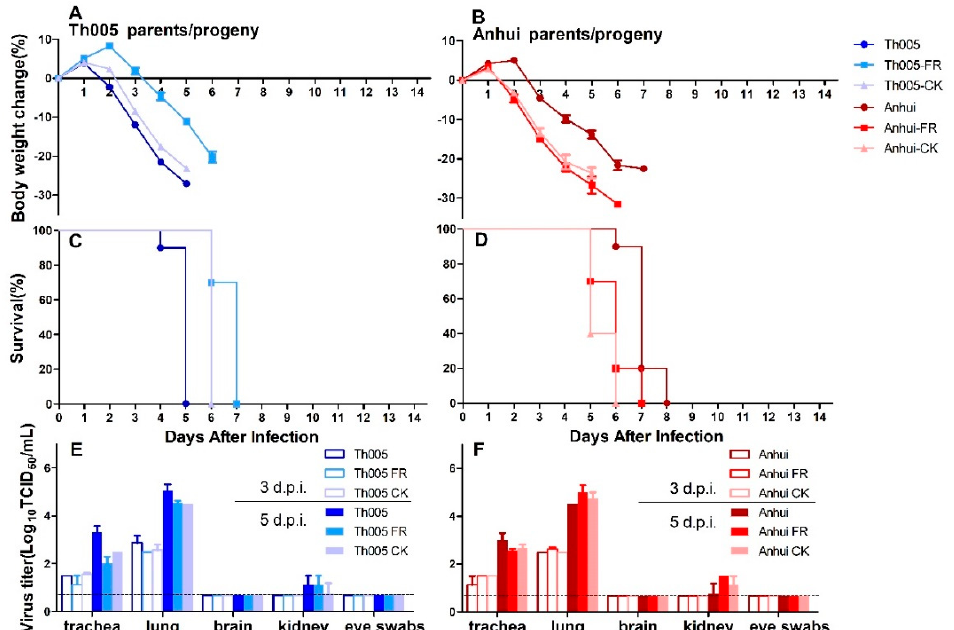
Figure 4. Pathogenicity of Th005, Th005 FR, Th005 CK, Anhui, Anhui FR, and Anhui CK infection in mice. Body weight change rate: ( A )Th005, Th005 FR, and Th005 CK. ( B )Anhui, Anhui FR, and Anhui CK. Survival rate: ( C ) Th005, Th005 FR, and Th005 CK. ( D )Anhui, Anhui FR, and Anhui CK. Viral titers in mice viscera after infection: ( E ) Th005, Th005 FR, and Th005 CK. ( F ) Anhui, Anhui FR, and Anhui CK. The results of A-D are displayed as means and SD from duplicates from ten independent mice, and the results of E, F are displayed as means and SD from duplicates from five independent mice.